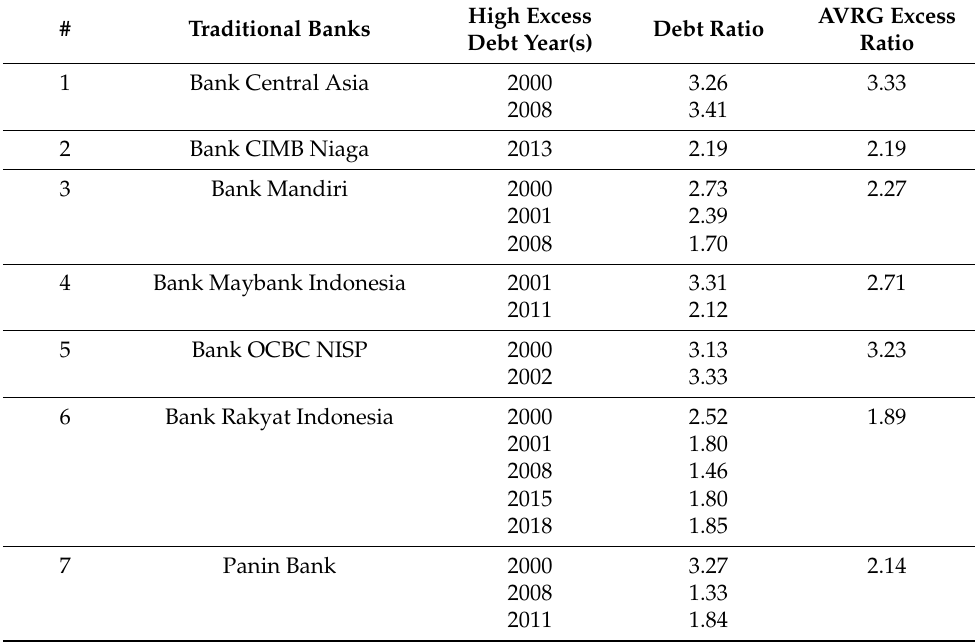
Table 1. High Excess Leverage among Conventional Banks.